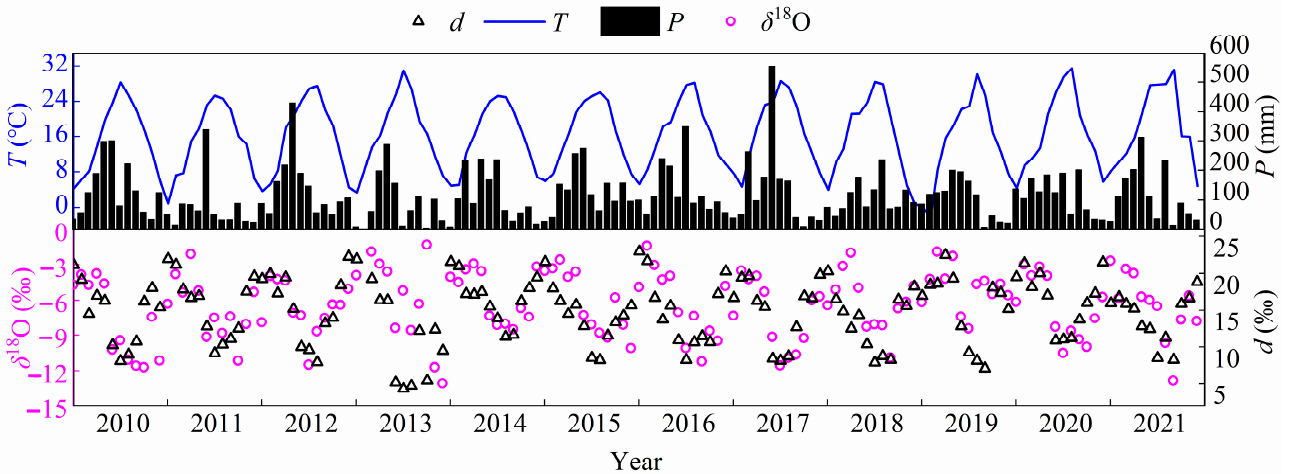
Figure 3. Temporal variations in monthly temperature ( T ), precipitation ( P ), δ 18 O p and d- excess ( d ) in Changsha. in